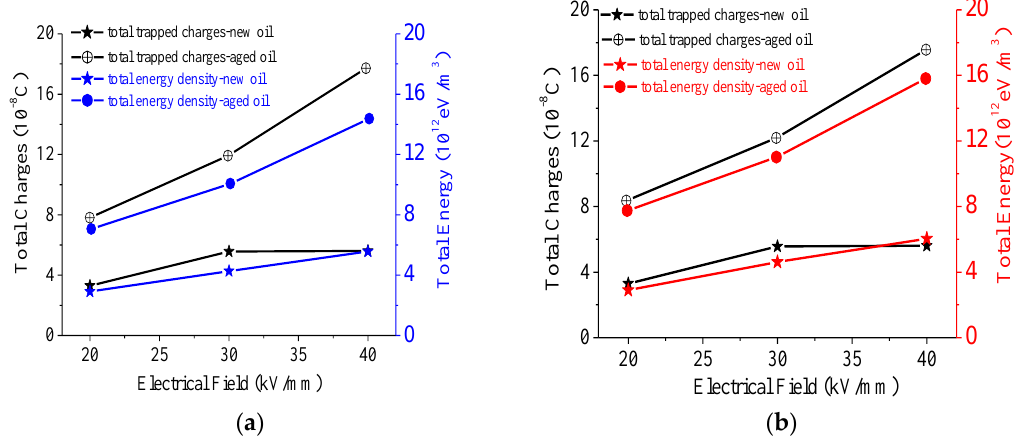
Figure 12. Relationship between the trapped charges amount and the total energy filled by the traps obtained by common method and the improved method. ( a ) common method; ( b ) improved method.